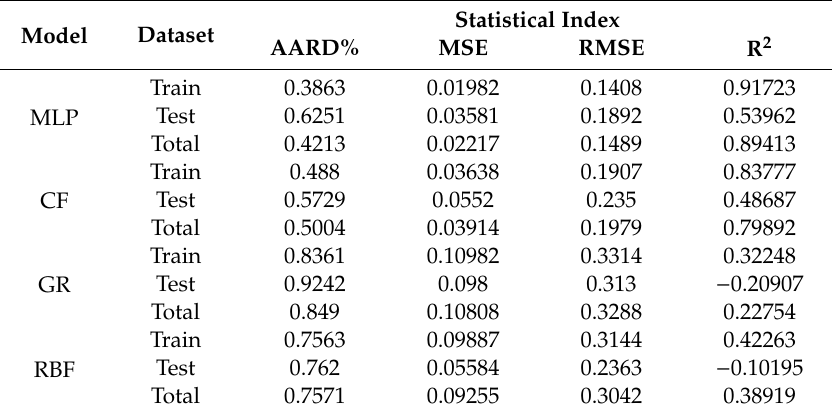
Table 8. A performance comparison of ANN models.